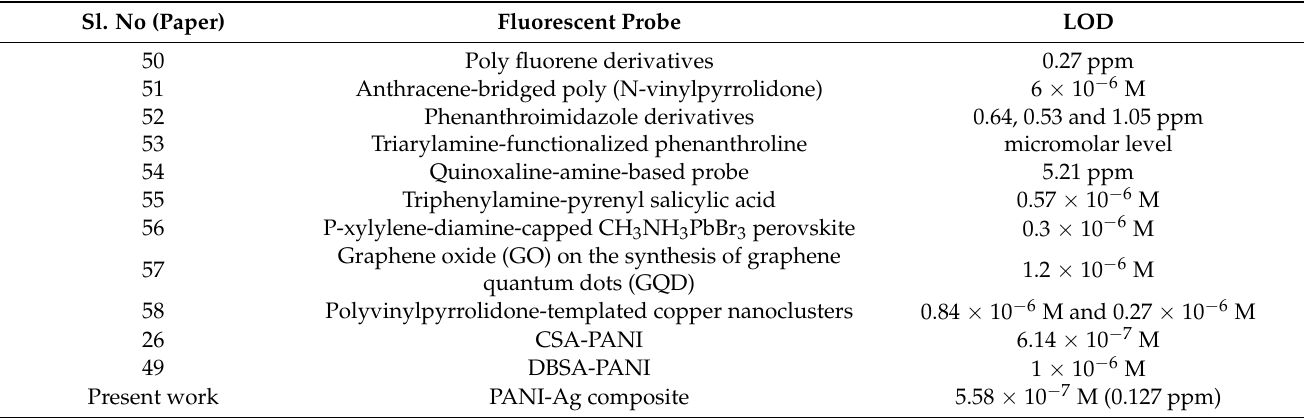
Table 3. Limit of detection of variable fluorescent probes with